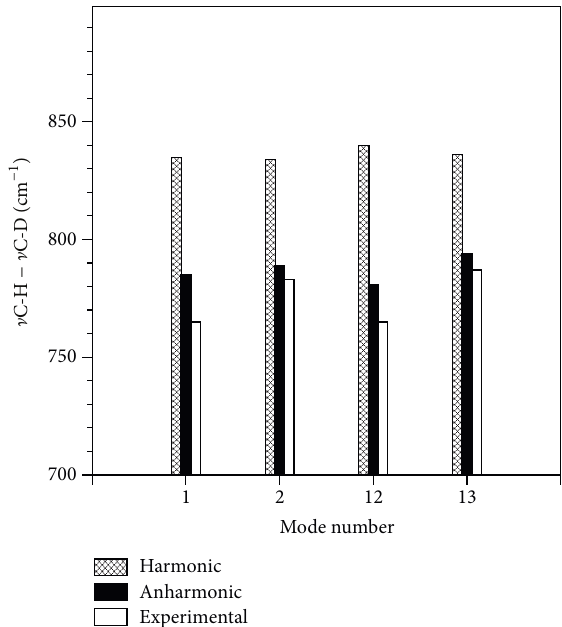
Figure 7: H/D isotopic wavenumber shifts for the C–H stretching modes between C 4 H 4 Se and C 4 D 4 Se. Comparison between